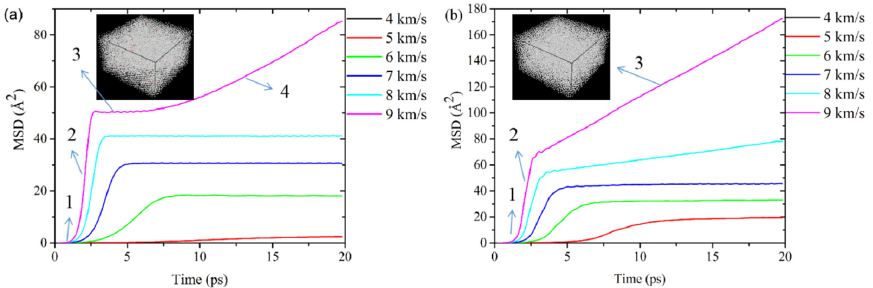
Table 2. Diffusion coefficients of the voids-free system for different shock wave velocities.